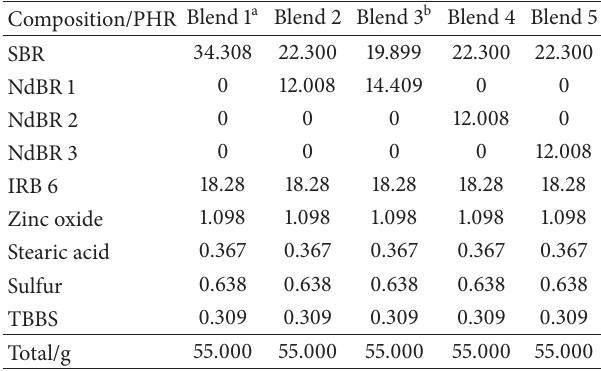
Table 4: Composition of blends for